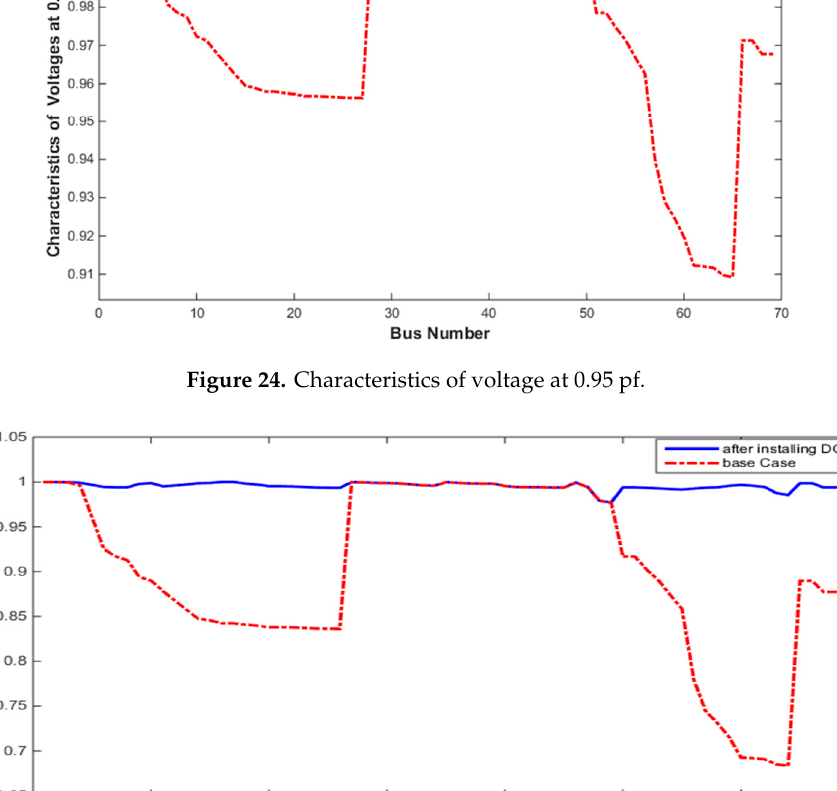
Figure 25. Characteristics of VSI, 0.95.